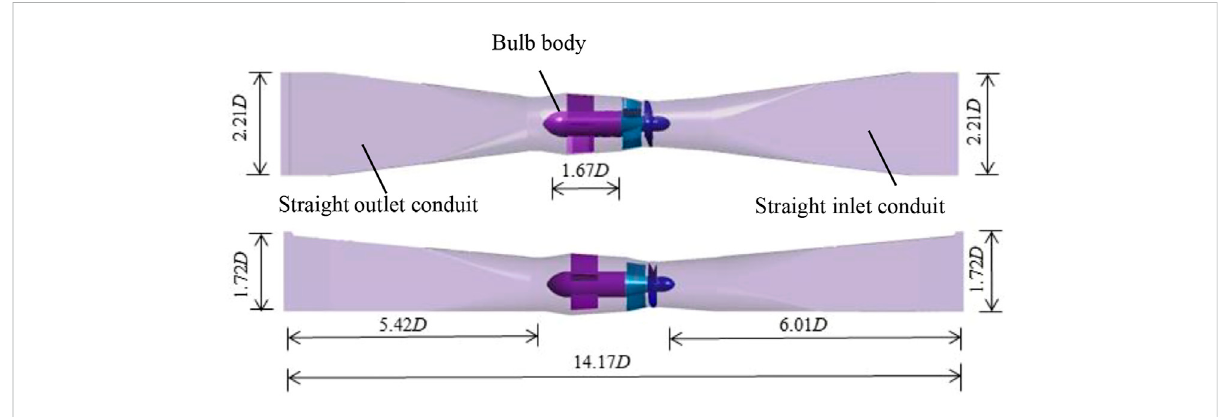
FIGURE 1 Dimensional drawing of the whole submersible tubular electric pump device.